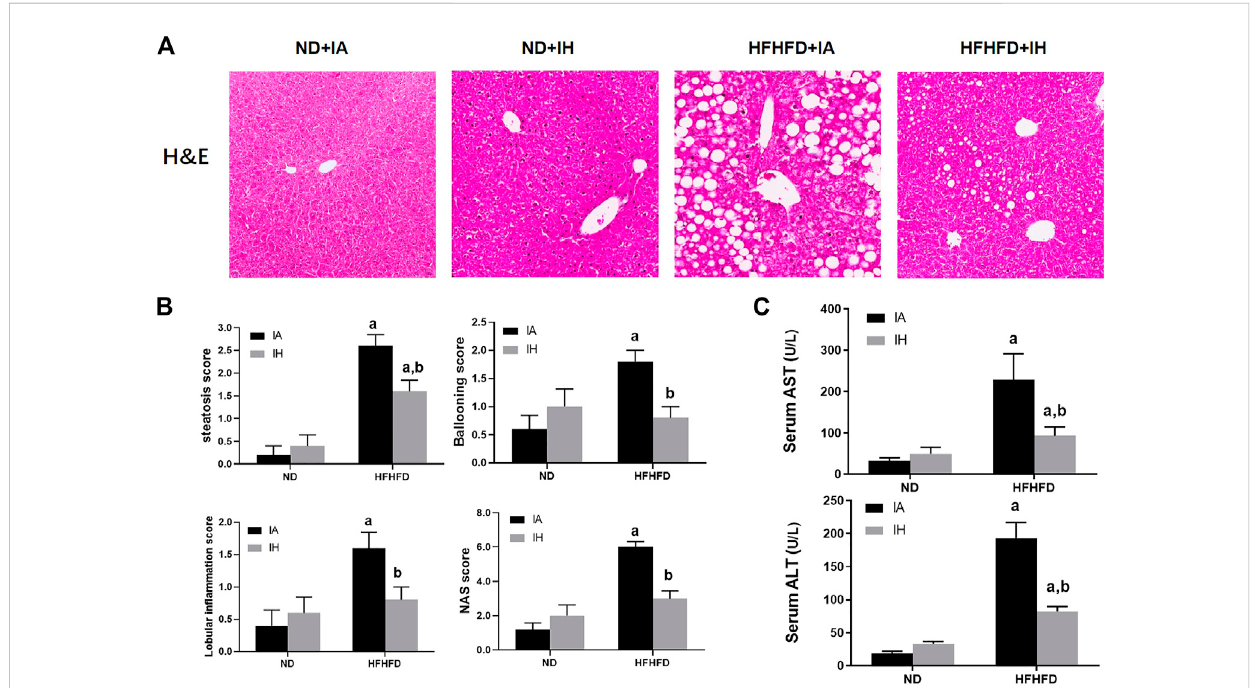
FIGURE 3 IH decreased liver injury caused by HFHFD. (A) Representative photomicrographs of H&E (general morphology, 200x) are shown of mice sacri fi ced at15 weeks. (B) Scoresforsteatosis,ballooning,lobularin fl ammationandNASforthefourexperimentalgroups. (C) Serumtransaminase(ALT/AST)levels were determined for all the experimental groups at the 15-week time point. a, p < 0.05 compared to ND control, b, p < 0.05 compared to absence of IH. Samples size per group n = 4 –